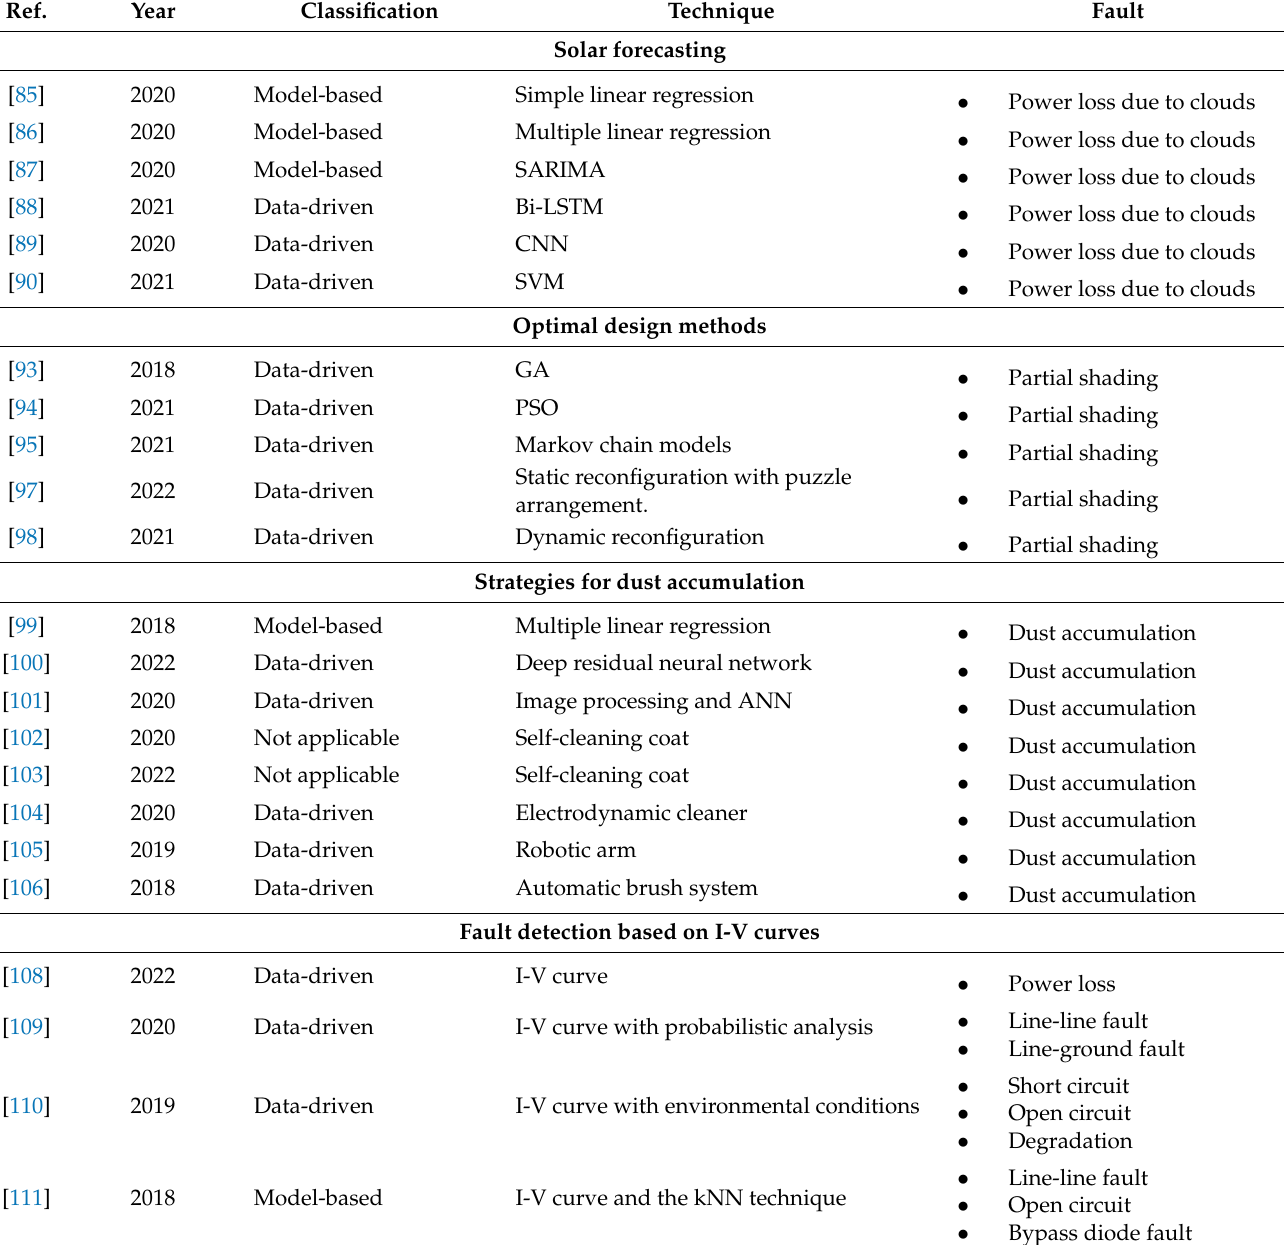
Table 2. Summary of the main techniques for fault detection in SPV systems.